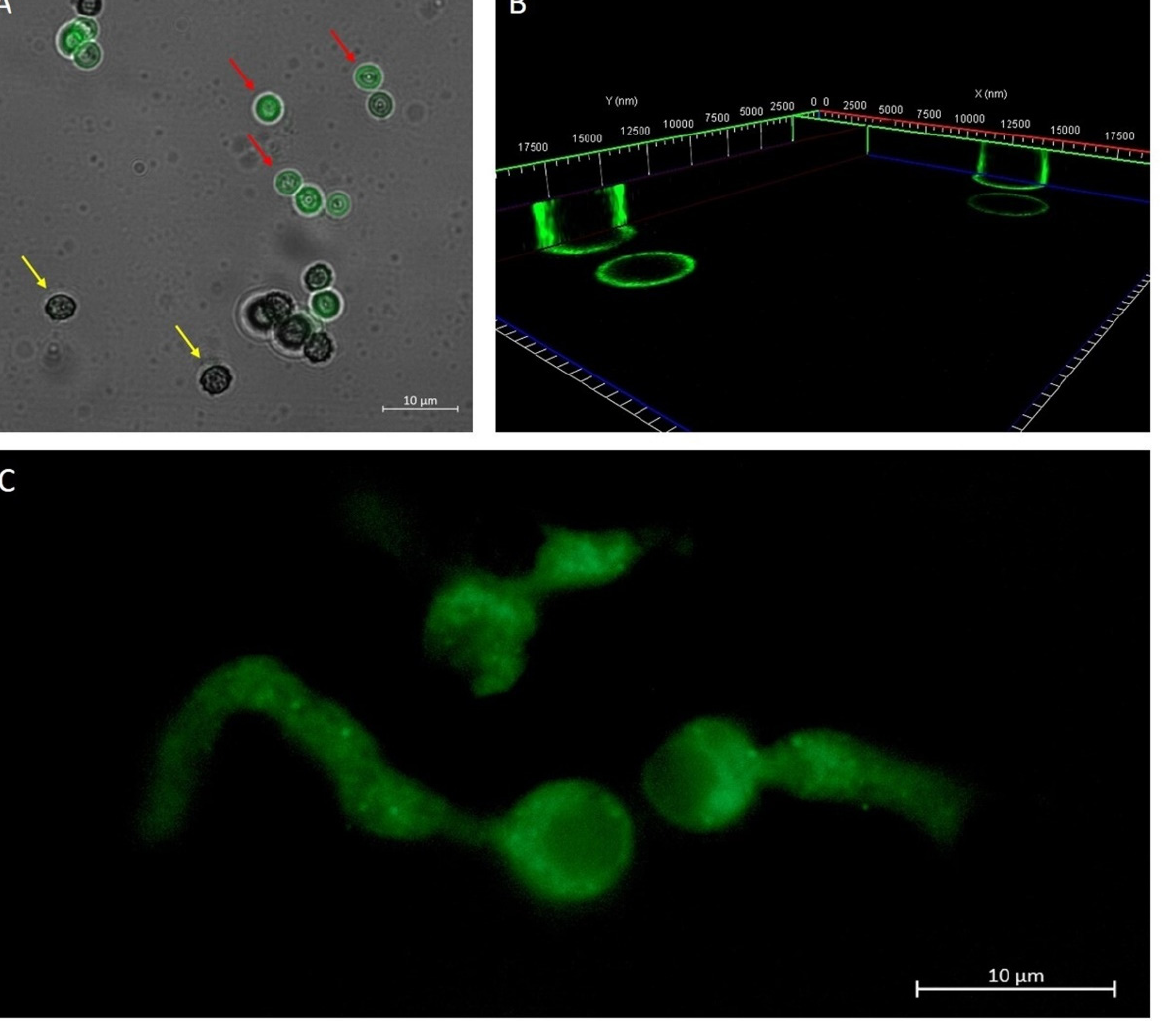
Figure 2. Overlap of the bright field image and the fluorescence image, which shows A. brasiliensis conidia treated for 10 min with 50 nm PLGA-coumarin6-NPs. In the first stage of conidia development (yellow arrow) the protective envelope did not allow interaction with NPs. In a later stage of conidia development (red arrow), when the envelope broke, fluorescence along the conidia capsule was observed ( A ). A 3D reconstruction of A. brasiliensis conidia treated with NPs for 10 min. The fluorescence signal was detected along the wall of the conidia ( B ). Fluorescence image of the hyphae of the newly germinated A. brasiliensis conidium treated with 50 nm PLGA-coumarin6 -NPs. The fluorescence signal inside A. brasiliensis hyphae is visible after 1 h of NPs administration ( C ).